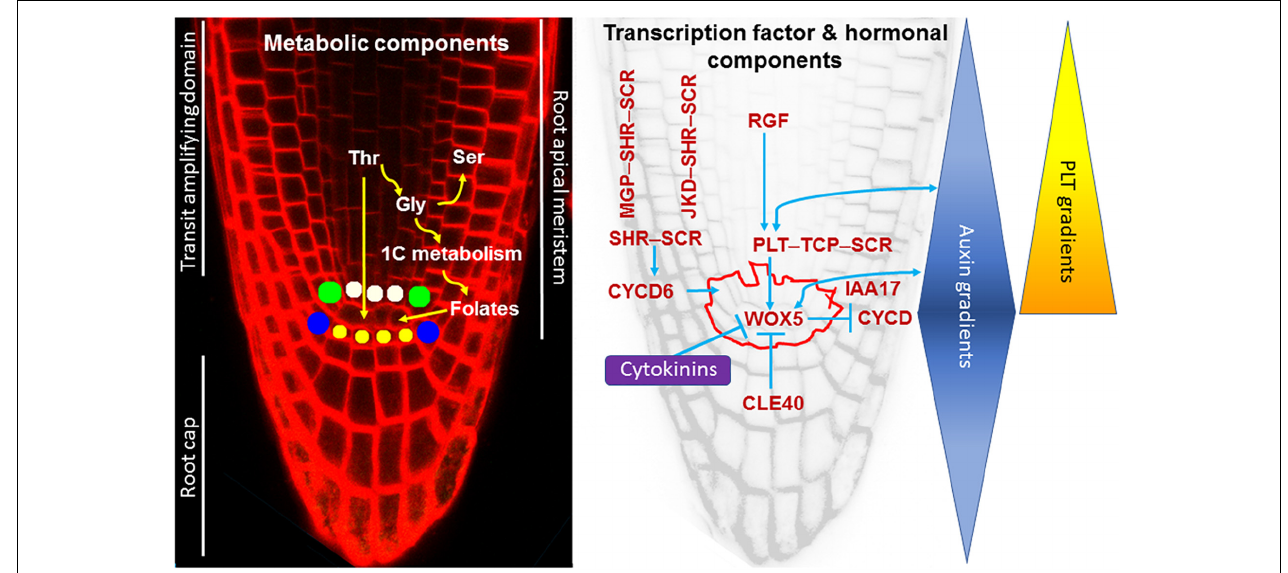
FIGURE 2 | Organization of the root apical meristem (RAM) and control of stem cell function. Left, A. thaliana root apex and metabolic components of the stem cell maintenance. Stem cells surrounding the quiescent center (QC) are the following: yellow stem cells form columella; blue stem cells give rise to the lateral root cap and epidermis; green stem cells give rise to ground tissues (cortex and endodermis) and cells marked with white give rise to central cylinder tissues. Root apex includes the RAM and the root cap. Transit-amplifying domain includes derivatives of the stem cells. Right, a gene regulatory network for RAM maintenance and its interaction with plant hormones, auxin, and cytokinins. Outlined area represents the QC and stem cells. See the text for details. A member of the AUX/IAA family of transcriptional regulators, IAA17, is an intermediate between auxin and WOX5 (Tian et al., 2014). Other details can be found in Shimotohno and Scheres (2019). Auxin and PLT gradients have a maximum in the